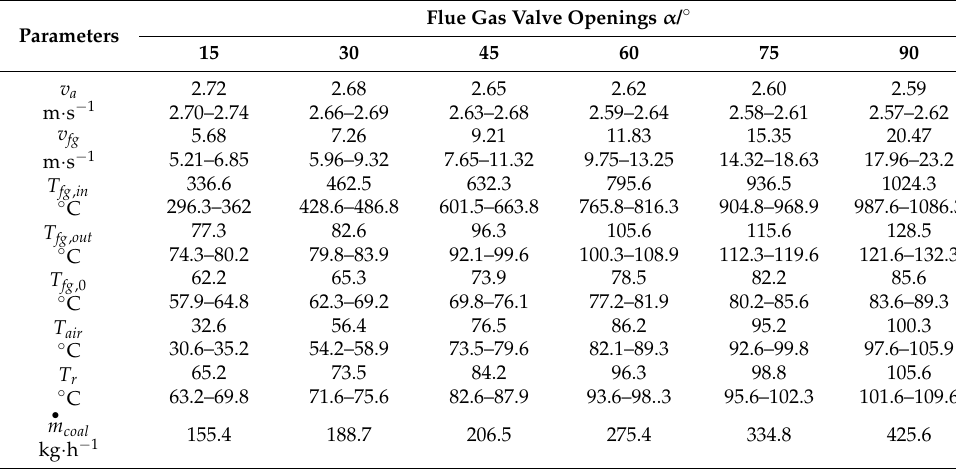
Table 3. The experimental data of the